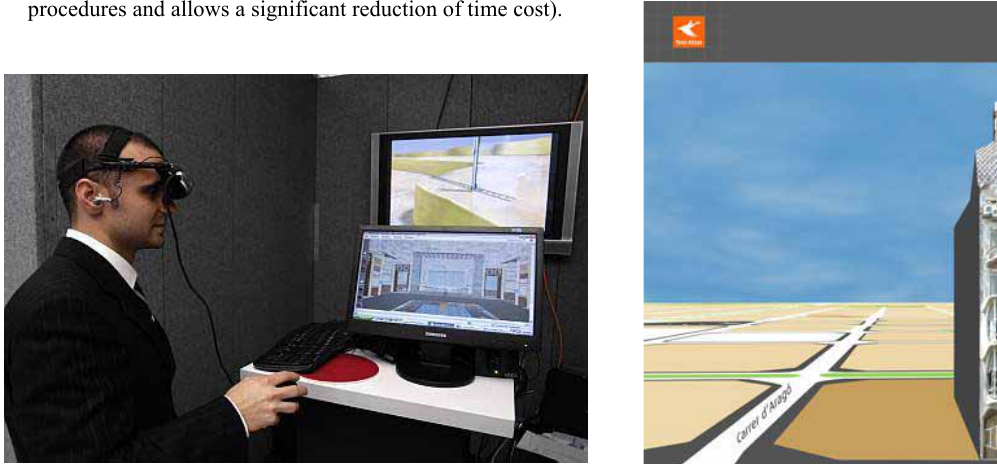
Figure 7. An example of three-dimensional processing by Tele Atlas. These calculations are designed to allow motorists and pedestrians to orient themselves more easily showing the representation of the destination. Due to the potential of three- dimensional representation, the images shown on navigation systems better reflect what users actually see around them. According to a recent survey, 81% of current and potential users of navigation systems has expressed a preference for the 3D representation